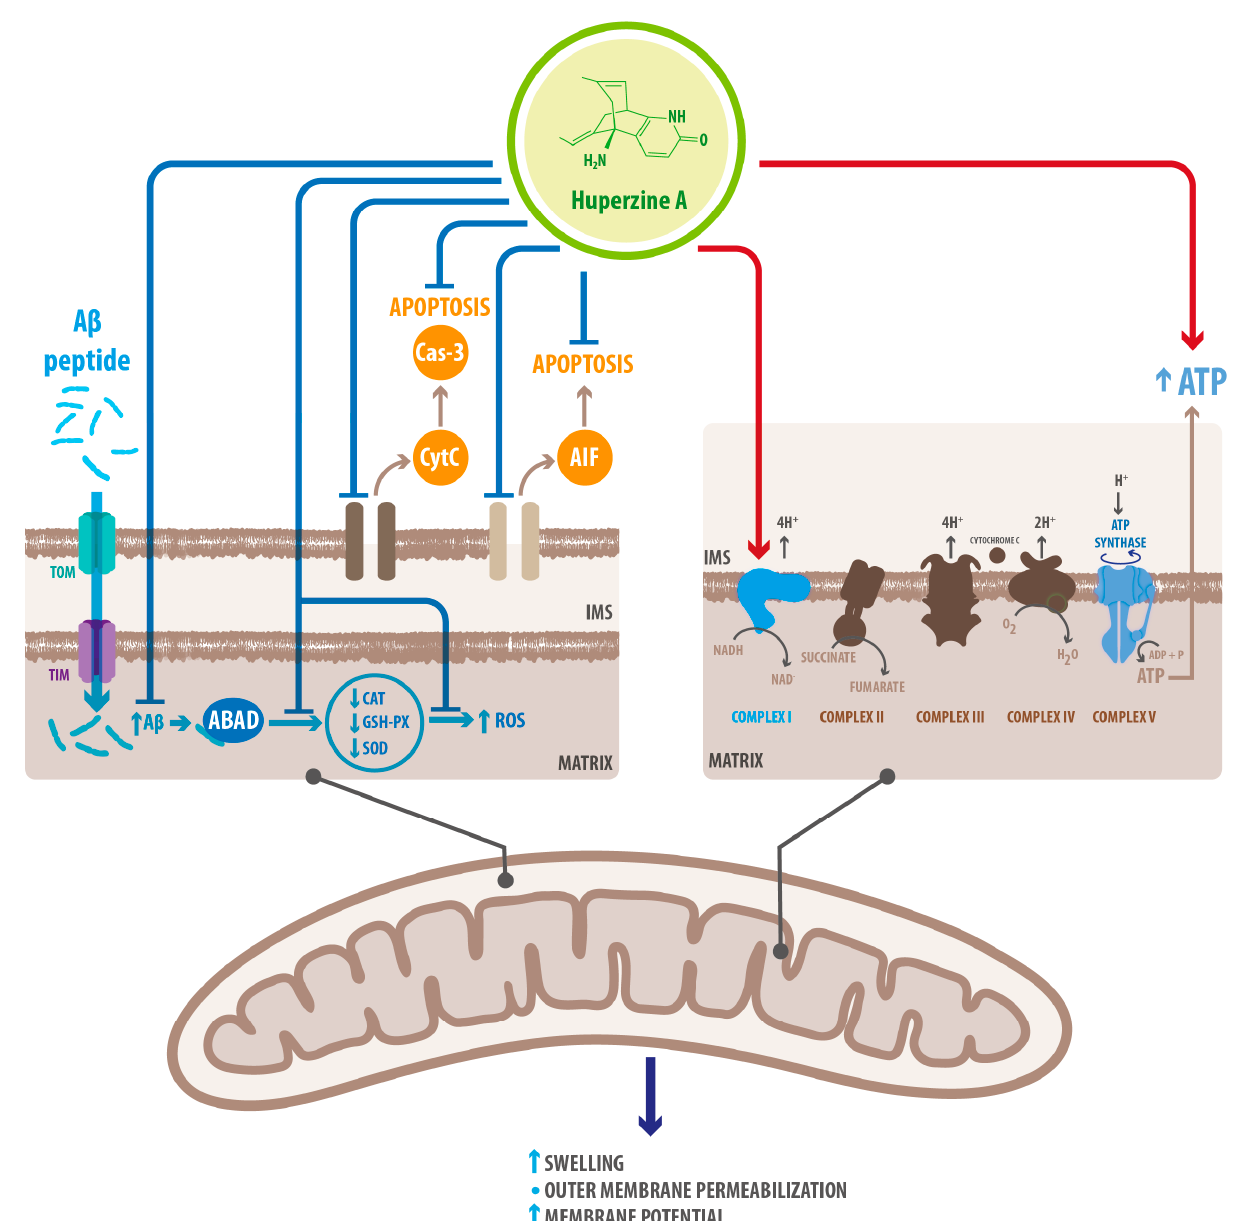
Figure 5. HupA rescues mitochondrial integrity after exposure to A β . A β crosses the mitochondrial double membrane and aggregates in the matrix. Mitochondrial perturbations include changes in morphology, compromised TCA cycle and reduced CytoC oxidase activity. Cell death is initiated by releasing proteins from intermembrane and intracristal spaces which activates caspases and AIF (caspase-independent apoptosis pathway). Outer membrane permeabilization leads to mitochondrial metabolic failure with subsequent mitochondrial swelling, ROS accumulation and neuronal death. HupA treatment prevents A β accumulation in the matrix as well as A β interaction with mitochondrial proteins. HupA prevents the release of CytoC and subsequent apoptosis. It also rescues overall membrane stability, thus protecting mitochondrial enzymatic activity, membrane potential, and ATP formation. HupA also enriches proteins involved in oxidative phosphorylation, improving mitochondrial respiration (ABAD: amyloid beta-binding alcohol dehydrogenase; CAT: catalase; GSH-PX: glutathione peroxidase; SOD: superoxide dismutase; ROS: reactive oxygen species; IMS: intermembrane space; CytoC: cytochrome C; Cas-3: caspase-3; AIF: apoptosis inducing